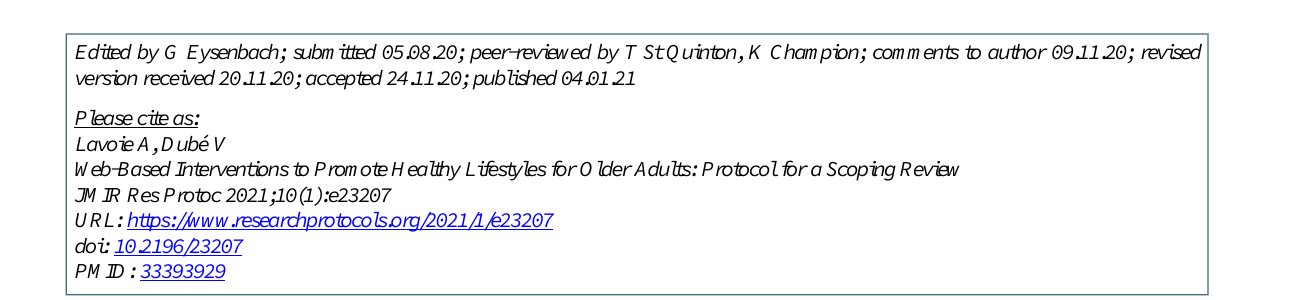
Edited by G Eysenbach; submitted 05.08.20; peer-reviewed by T St Quinton, K Champion; comments to author 09.11.20; revised